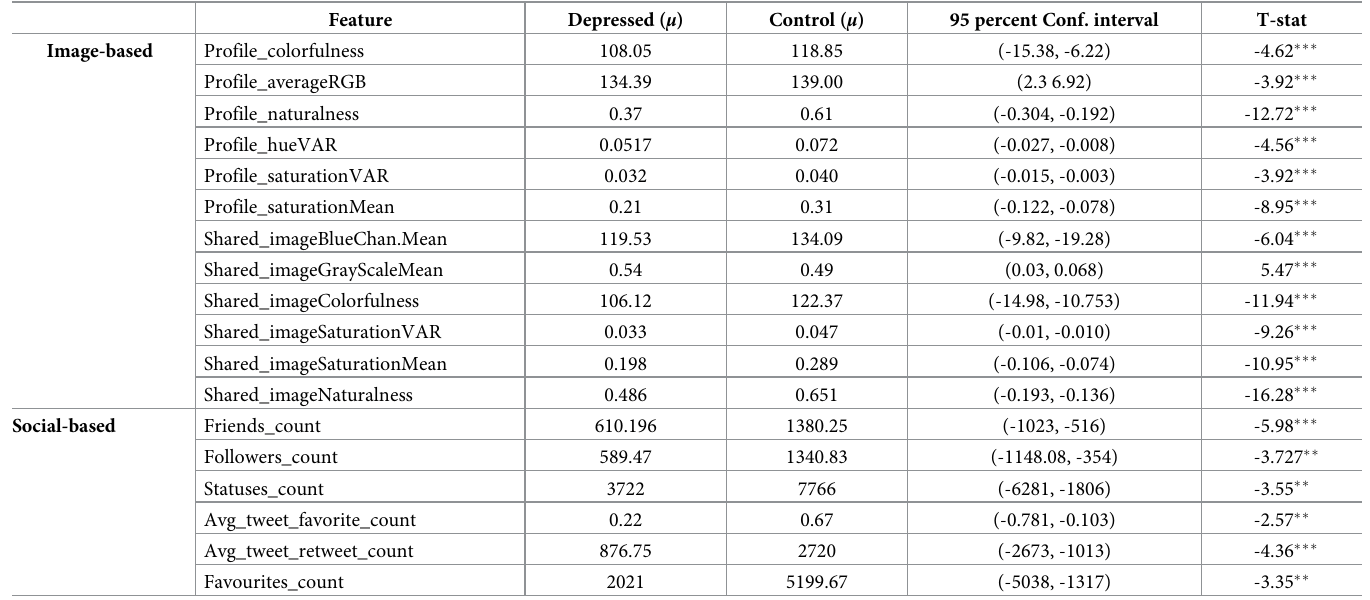
Table 4. Statistical significance (t-statistic) of the mean of salient features for both depressed and control classes— �� alpha = 0.05, ��� alpha =